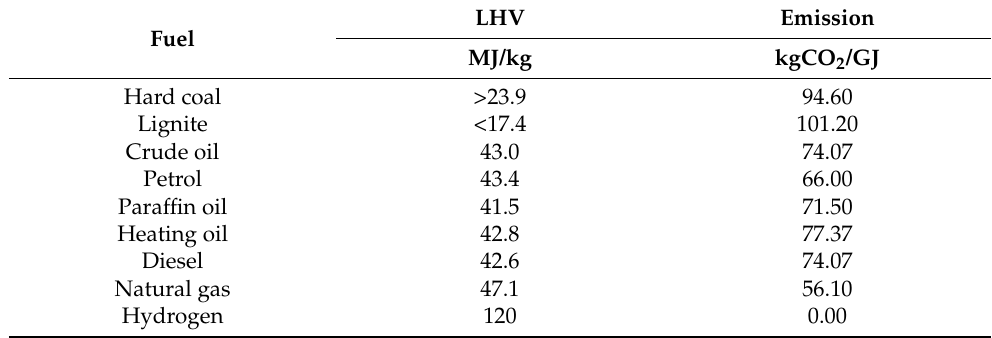
Table 1. Emission of carbon dioxide (CO 2 ) during combustion of different hydrocarbon fuels [1–3,8].